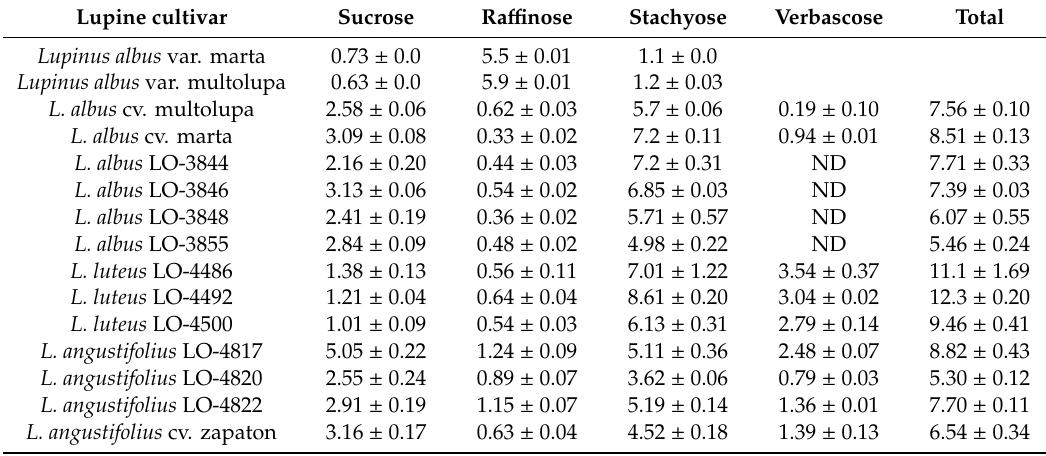
Table 4. Oligosaccharide content of lupine cultivars (g / 100 g DM). Lupine cultivar